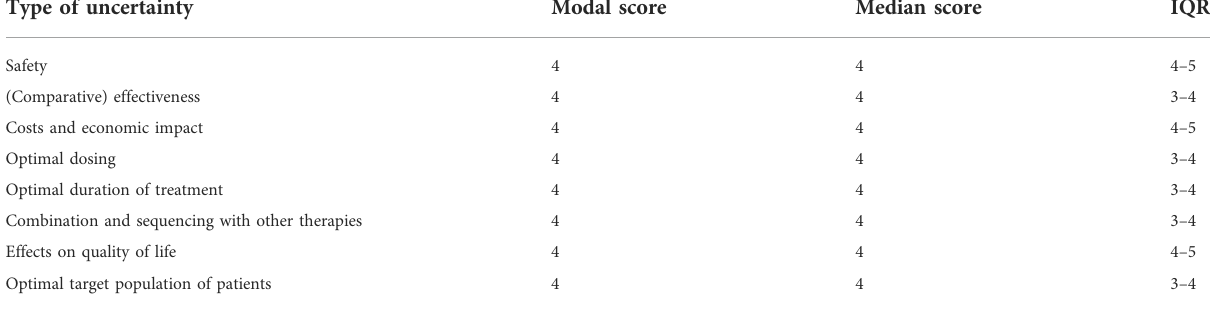
TABLE 1 Breakdown of how participants perceived the suitability of RWD for tackling various uncertainties related to the integration of new anticancer treatments into clinical practice, expressed on a scale of 1 (equivalent to highly unsuitable) to 5 (equivalent to highly